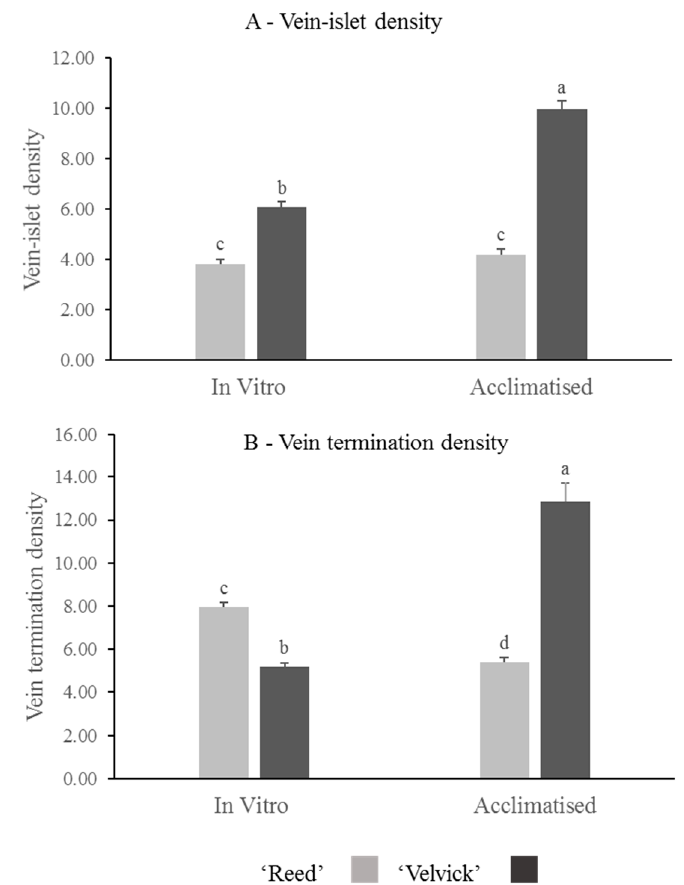
Figure 9. The difference in vein-islet density ( A ) and vein termination density ( B ) of avocado rootstocks at in vitro and acclimated stages, as well as changes occur in individual rootstocks during transition. ‘Velvick’ had significantly higher vein-islet density in both in vitro and acclimated leaves compared to ‘Reed’. Vein termination density was higher in ‘Reed’ at in vitro stage but lower at acclimated stage compared to ‘Velvick’. Vein islet density remained unchanged from in vitro acclimation with ‘Reed’, but vein termination density was significantly reduced. For ‘Velvick’ both vein-islet density and vein termination density were significantly increased. The letters a, b, c, and d indicate significantly different values within a tested stage between two rootstocks and between the two satges (in vitro and acclimated) at confidence level p = 0.001, n = 10 with two replicates and error bars indicate standared error.